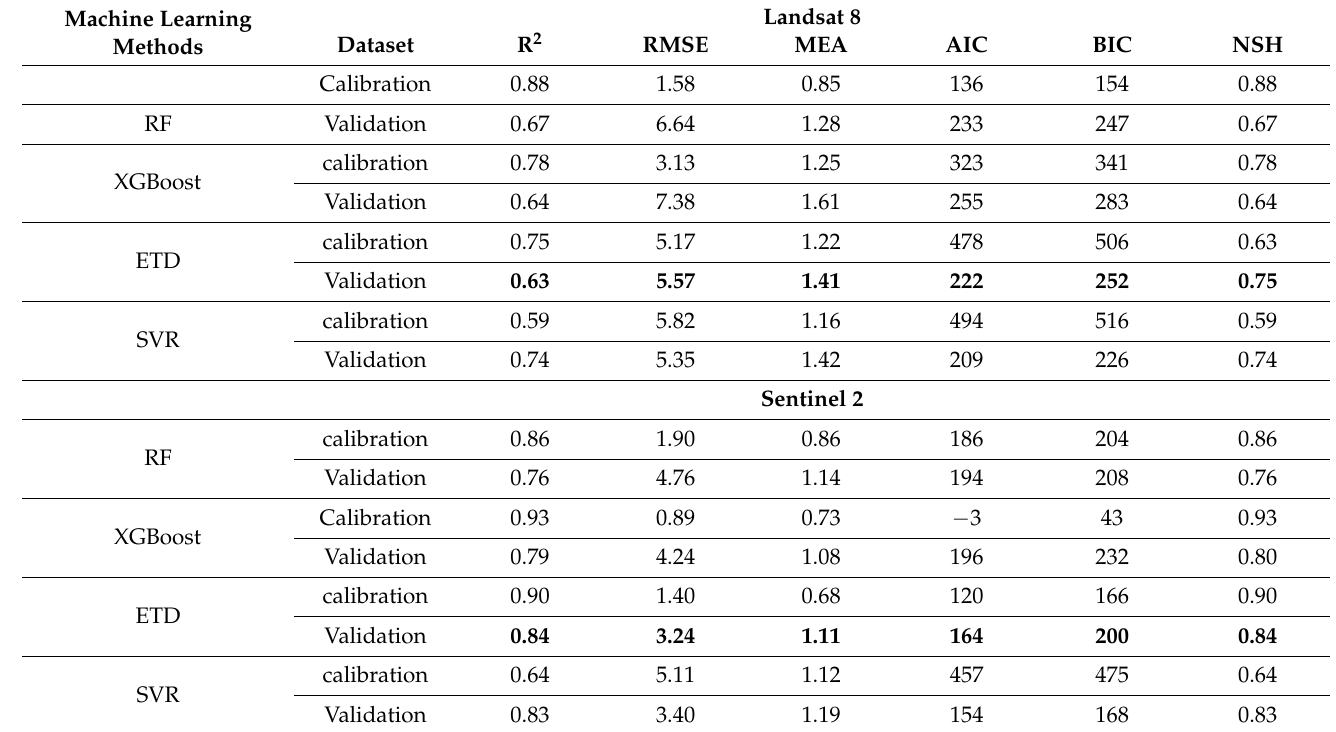
Table 8. Four machine learning methods (RF, XGBoost, ETD, and SVM) used without segmentation to predict SMC. Best validation results are